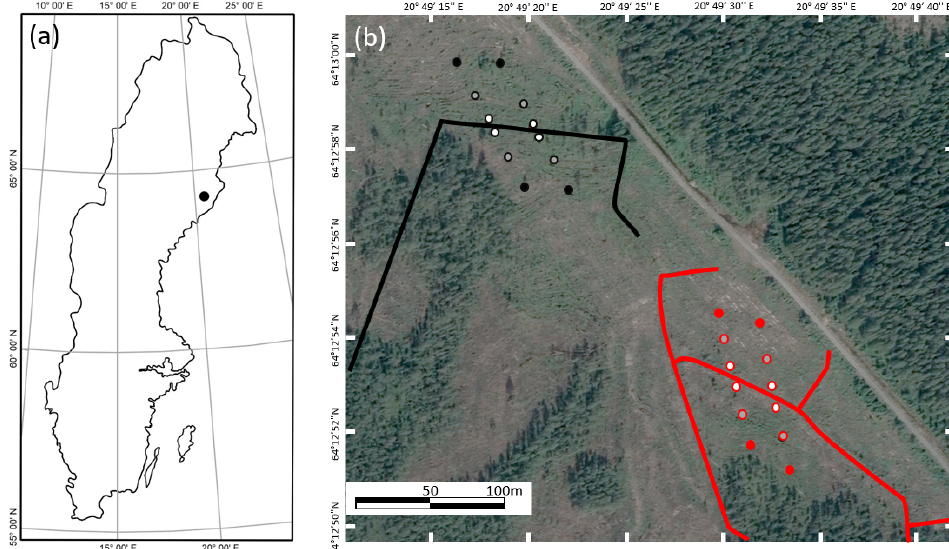
Figure 1. ( a ) Location of the Pettersson study site in boreal Sweden, and ( b ) map of ditch network at the Pettersson field site. Cleaned and uncleaned ditches are marked in red and black, respectively. The locations for flux measurements at 4 m, 20 m and 40 m distance from the ditch, respectively, are marked in red for the cleaned area and black for uncleaned area.